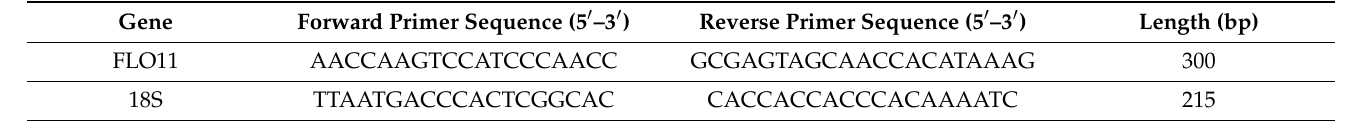
Table 1. qRT-PCR primer pairs used in this study.